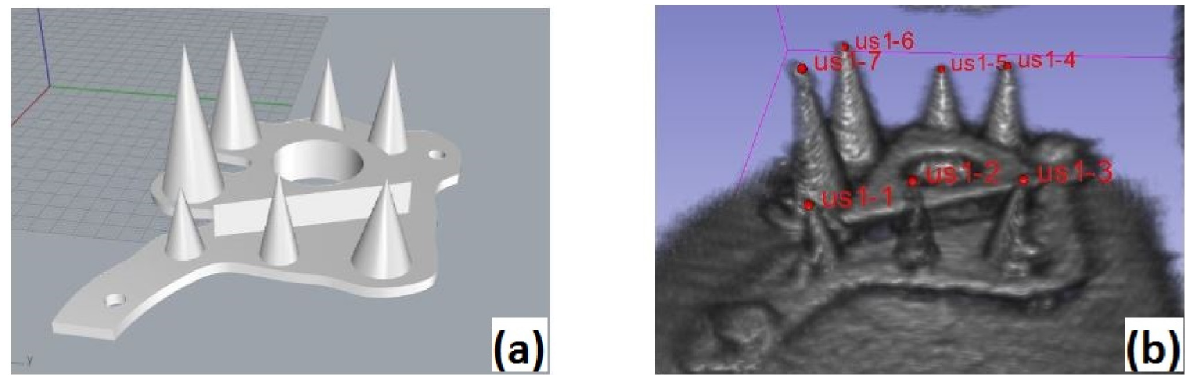
Fig 1. CAD model of the phantom for the 3D-US calibration (left) and its 3D ultrasound image on Slicer (right) with fiducials placed on the tips.